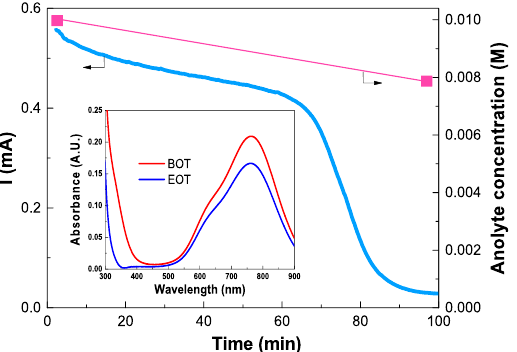
Figure 7. Continuous photocharging of the all-V continuous-flow PESC under AM 1.5 illumination using 0.01 M vanadium redox electrolytes. UV-Vis absorbance spectra of the BOT and EOT anolyte were shown in the inset. The BOT and EOT denote begin-of-test and end-of-test,